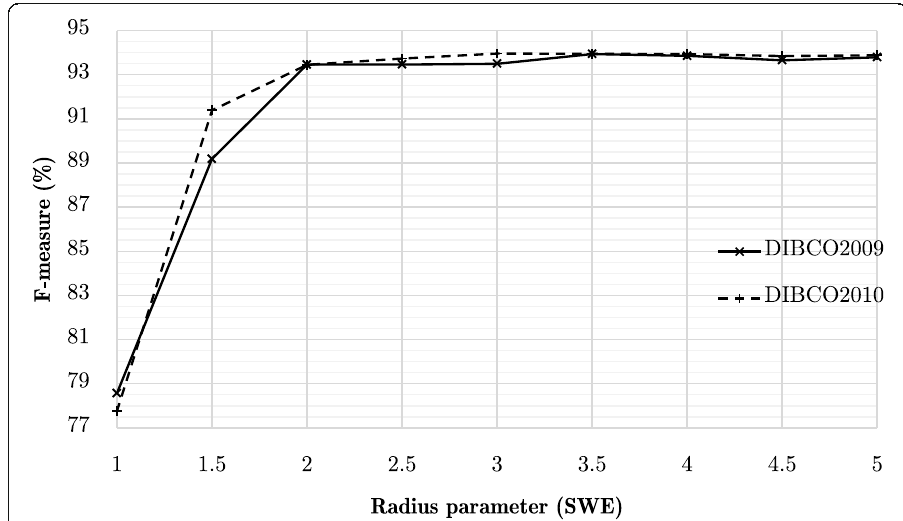
Fig. 6 F-measure vs. radius parameter settings over DIBCO 2009 and H-DIBCO 2010 datasets (SWE denotes the stroke width